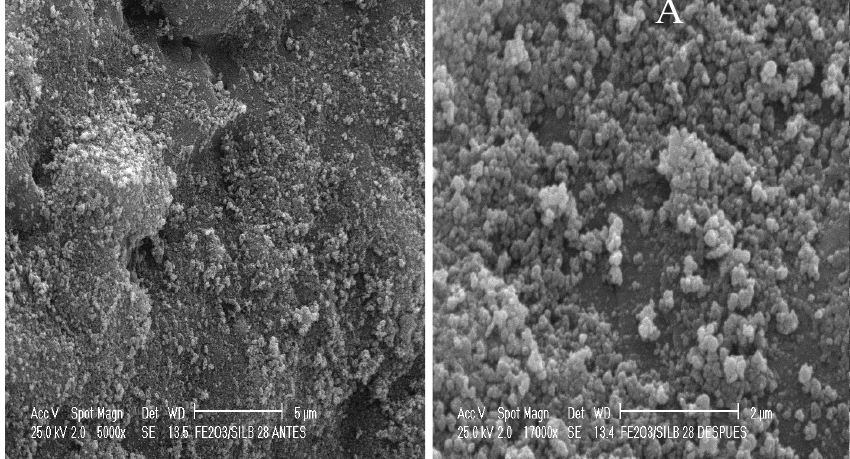
Figure 3. Scanning Electron Microscopy photographs of the Fe-60/SiO 2 catalyst ( A ) Before the upgrading reaction and ( B ) After the upgrading reaction (315 °C and 24 h, tetralin). Table 2. Characterization by X-Ray Photoelectron Spectroscopy (XPS) of the iron catalyst Fe-20/SiO 2